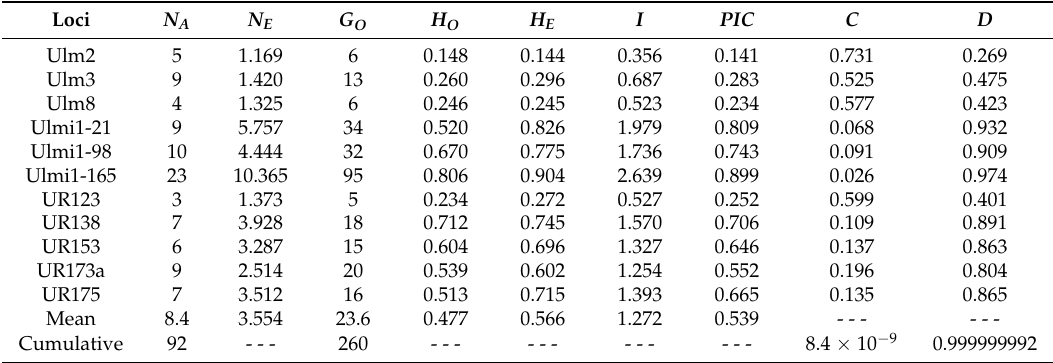
Table 2. Genetic diversity parameters at eleven microsatellite loci analyzed in 427 Ulmus glabra individuals from the Central System of the Iberian